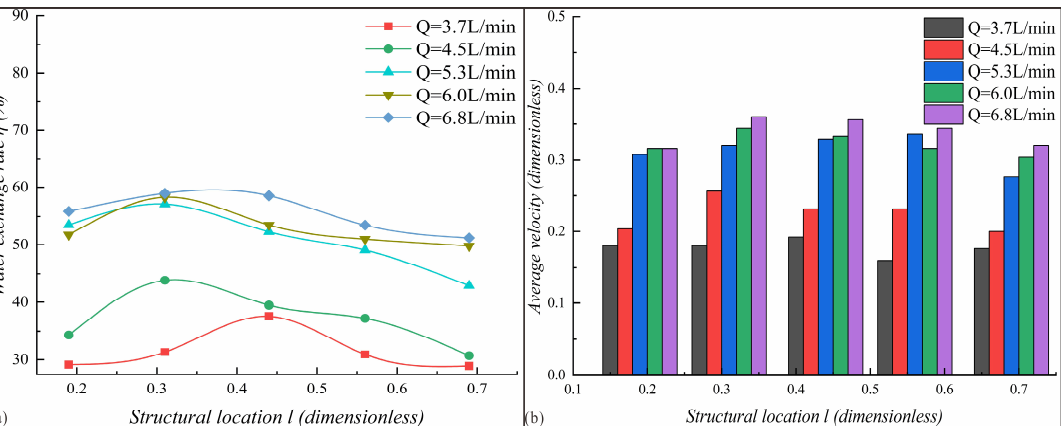
Figure 10. Calculation results for the semi-cylinder: ( a ) water exchange rate; ( b ) average velocity.